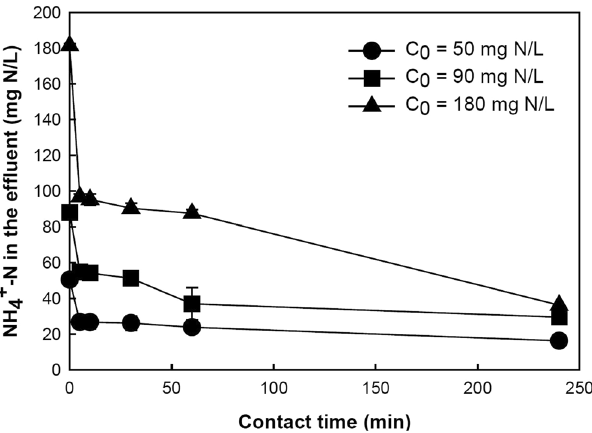
Figure 1. NH 4 -N concentration in the wastewater as a function of time after the addition of PAA hydrogels. The NH 4 -N concentration of the raw wastewater used for this experiment was 50 mg/L. Ammonium chloride was added to increase the NH 4 –N of the wastewater to 90 mg/L and 180 mg/L respectively. Sorption conditions: Contact time = 4 h, T = 23 °C, pH = 7.1. Error bars show the standard deviation from triplicate